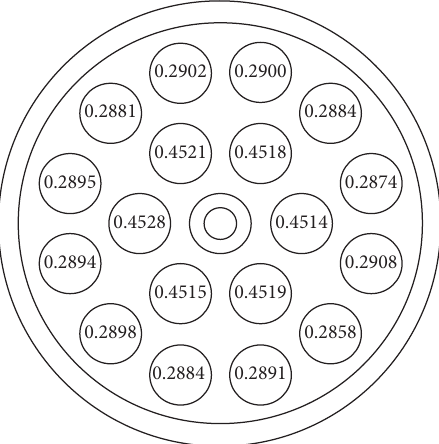
Figure 2: Location-specific DFs calculated by the MCDancoff module (RBMK-1500 case).